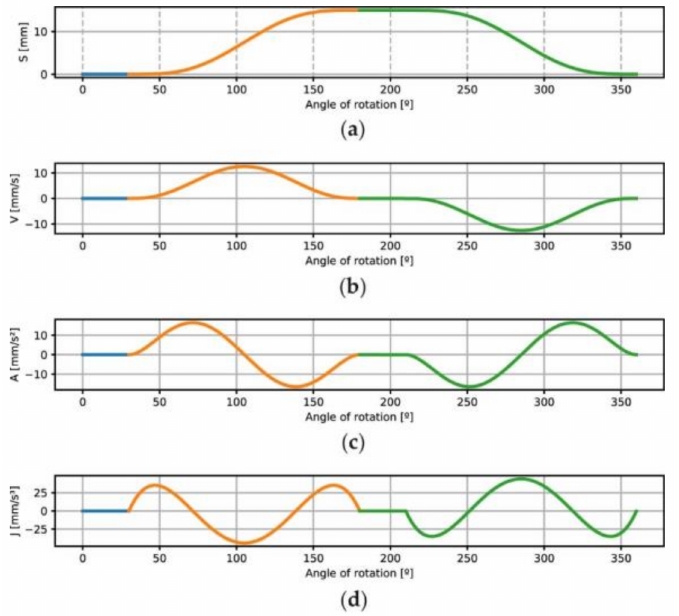
Figure 4. ( a ) The designed displacement law s ( θ ) and its derivatives: ( b ) the velocity curve V ( θ ) , ( c ) the acceletarion curve ( θ ) and ( d ) the jerk curve J ( θ ) .